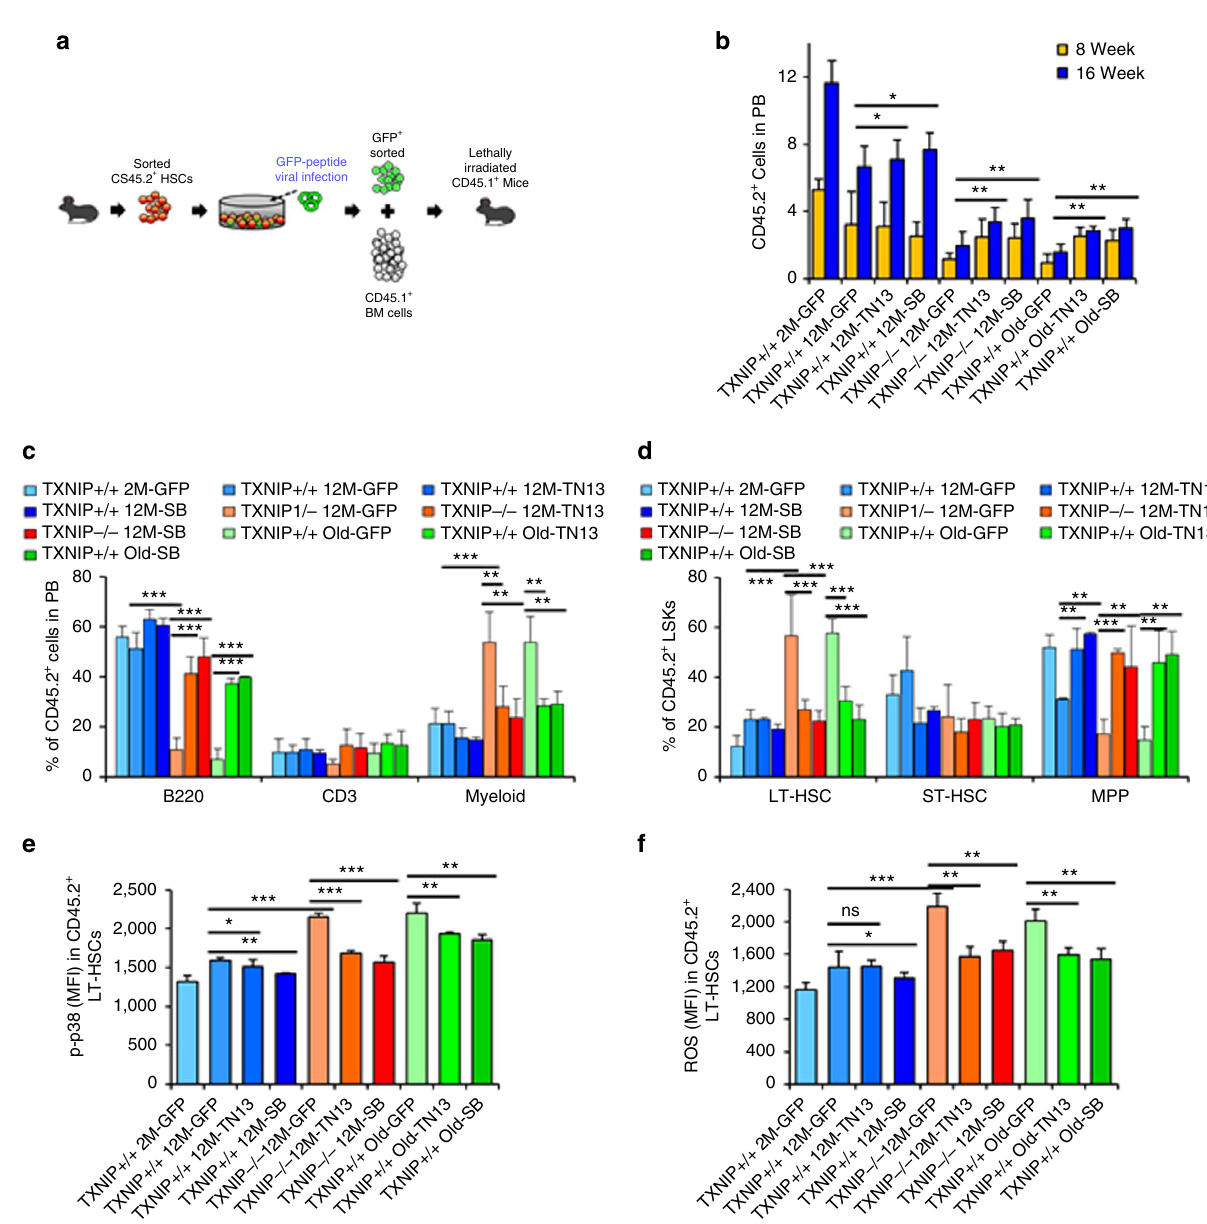
Figure 5 | Rejuvenation of aged HSCs by GFP-TN13-expressing lentiviral transduction in vivo . ( a ) Scheme of the experimental procedure for transplantation. Five hundred GFP þ LT-HSCs were i.v. injected with competitor BM cells ( CD45.1 þ , 1.5 (cid:3) 10 6 ) into lethally irradiated (9Gy) CD45.1 þ congenic recipients. ( b , c ) Distribution of donor-derived WBCs in PB ( b ) and percentage of B220 þ , CD3 þ and myeloid cells among donor-derived WBCs in PB ( c ) ( n ¼ 8–12). ( d – f ) LT-HSCs, ST-HSCs and MPPs among donor-derived LSKs in BM ( d ), levels of phospho-p38 ( e ) and levels of ROS in donor-derived LT-HSCs ( f ) ( n ¼ 5–7). Data are mean ± s.d. Statistical significance was determined using a two-tailed Student’s t -tests. * P o 0.05, ** P o 0.01, *** P o